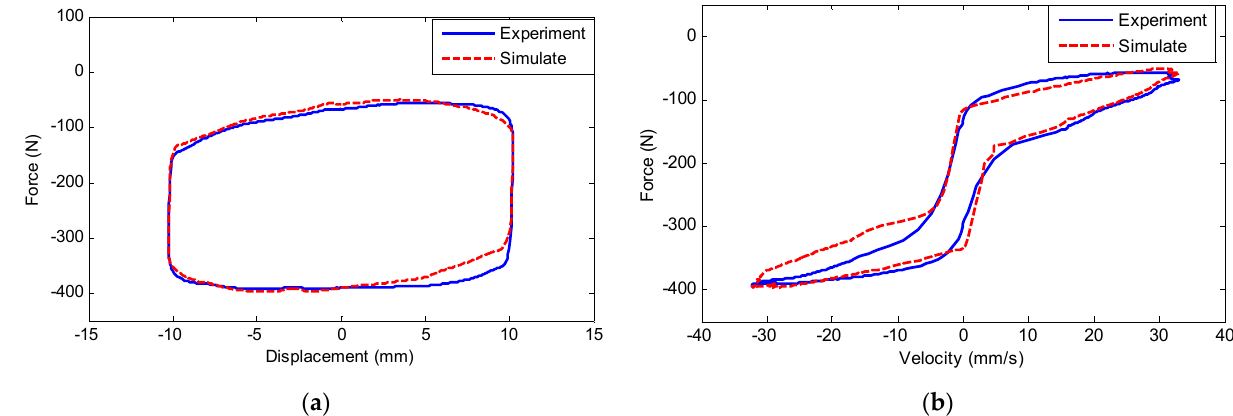
Figure 8. Comparisons of the simulation results with the experimental results: ( a ) force − displacement and ( b ) force − velocity under 0.5 Hz sinusoidal excitation of 10 mm amplitude for a control current of 0.25 A.